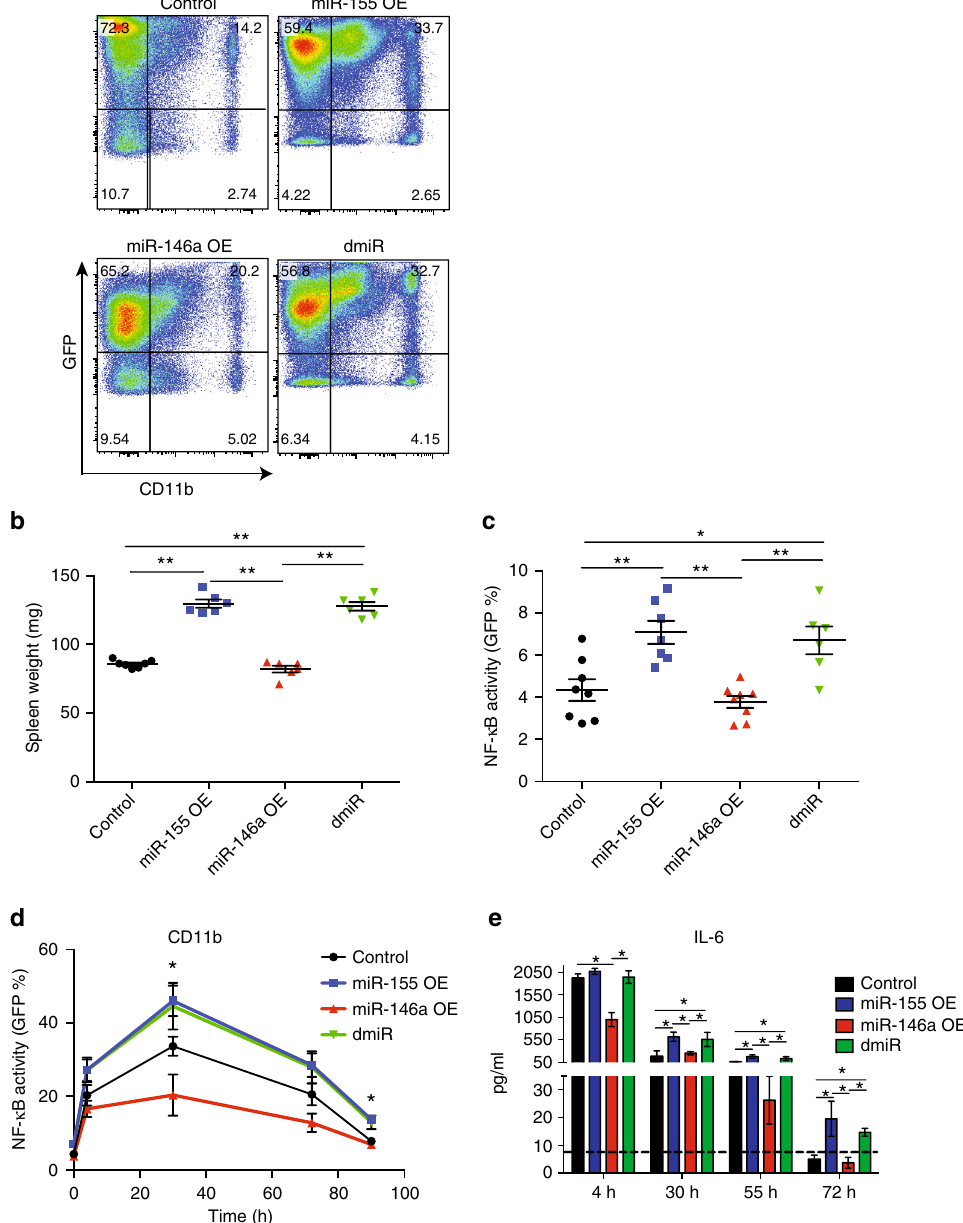
Fig. 3 MiR-155 overexpression overrides miR-146a repression of NF- κ B, leading to NF- κ B activation and myeloproliferation. a , b Mice reconstituted with bone marrow transduced with GFP and control (MG), miR-155, miR-146a or both miR-155 and miR-146a (dmiR) were analysed 4 months after reconstitution for ( a ) CD11b + peripheral blood macrophages and ( b ) spleen weight. c – e Mice reconstituted with bone marrow from NF- κ B reporter mice, transduced with control (MG), miR-155, miR-146a or dmiR were analysed 3 months after reconstitution. ( c ) Basal NF- κ B activity of CD11b + peripheral blood macrophages. ( d ) Mice received 1 mg/kg LPS every 24 h for 3 days via IP injections. Peripheral blood macrophage NF- κ B activation was quanti fi ed 4 h after each injection by GFP expression, as well as serum IL-6 levels ( e ). Dashed line represent ELISA detection sensitivity. N = 7 per group from three ( a – c ) or two ( d , e ) independent experiments and are represented as percentage ( a ) or mean ± SEM. * p < 0.05, ** p < 0.01, using one-way ANOVA ( b , c ) or